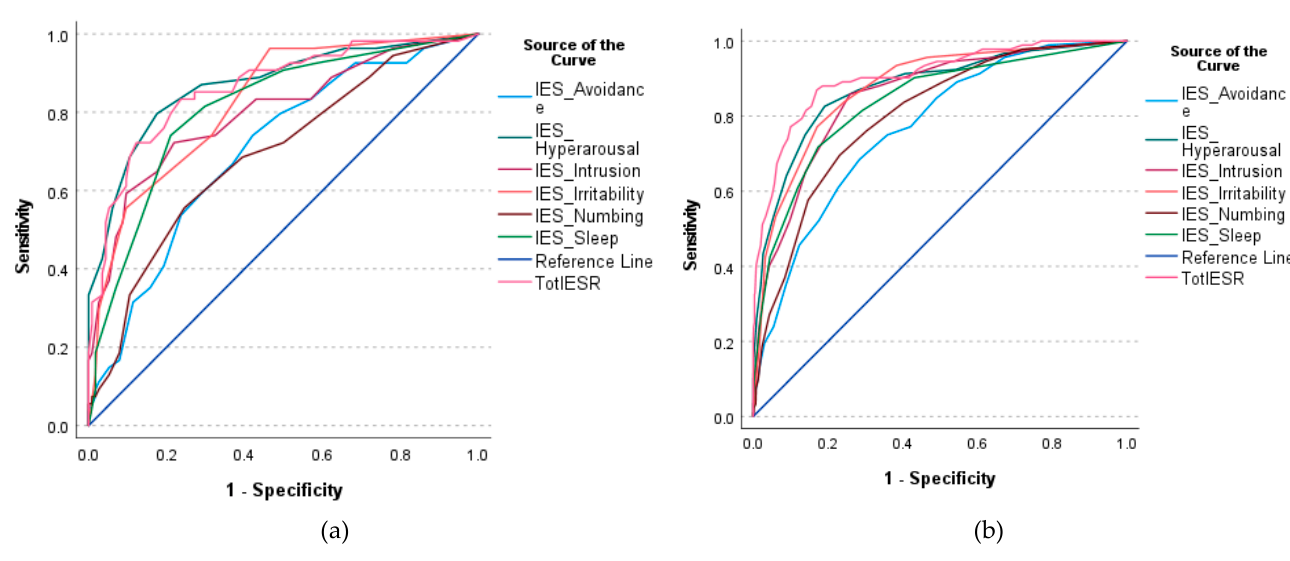
Figure 1. Receiver operating characteristic (ROC) curve using the scores of the Arabic version of the Impact of Event Scale-Revised (IES-R) and its subscales to classify people with mental disorders ( a ) and healthy adults ( b ) according to their self-reported level of distress as measured by the Depression Anxiety Stress Scale 8 (DASS-8).